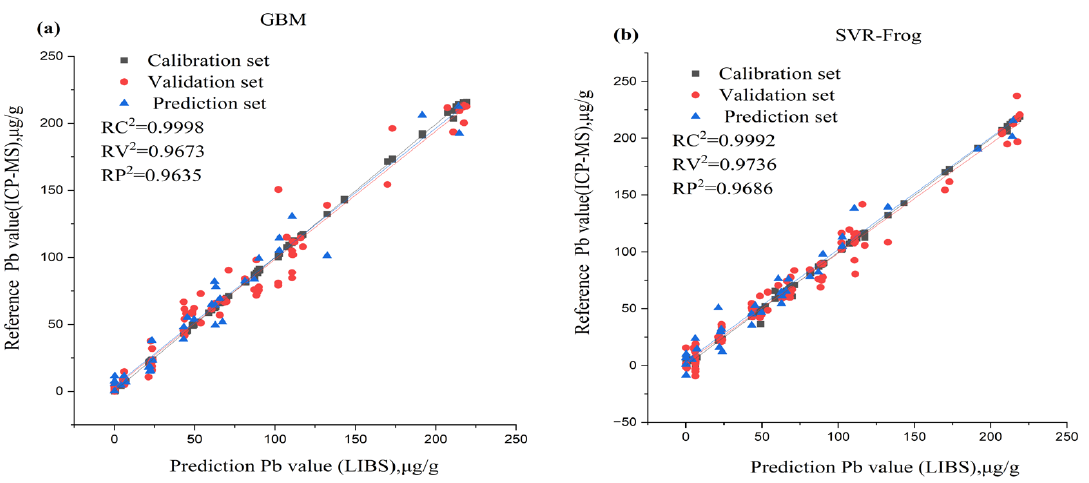
Figure 6. ( a ) Scatter plots of the full variables and reference value ( b ) Scatter plots of SVR combined with RF feature selection method and reference value for the content of Pb.